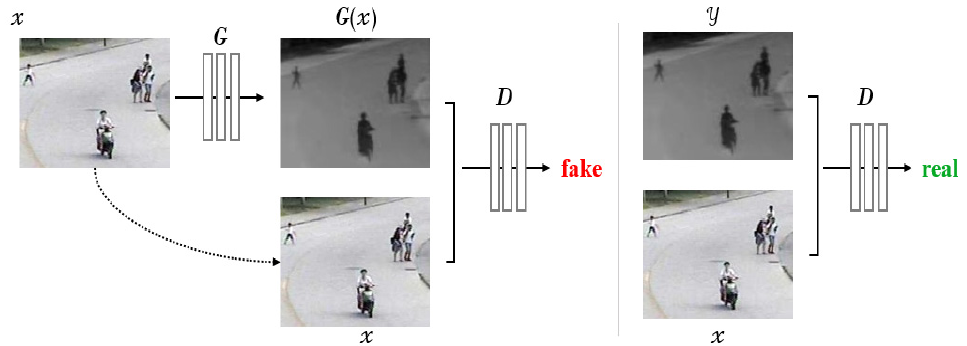
Figure 9. The framework of pix2pix network.